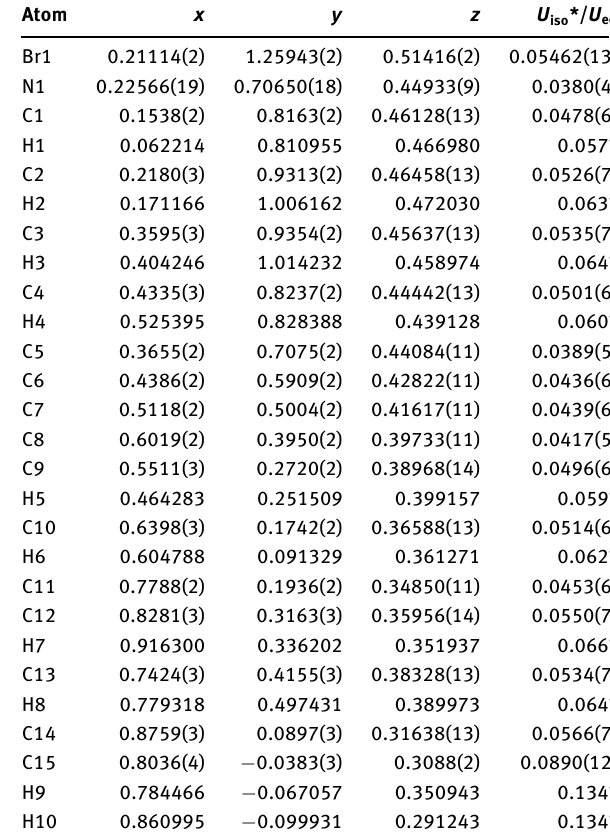
Table 2: Fractional atomic coordinates and isotropic or equivalent isotropic displacement parameters (Å 2